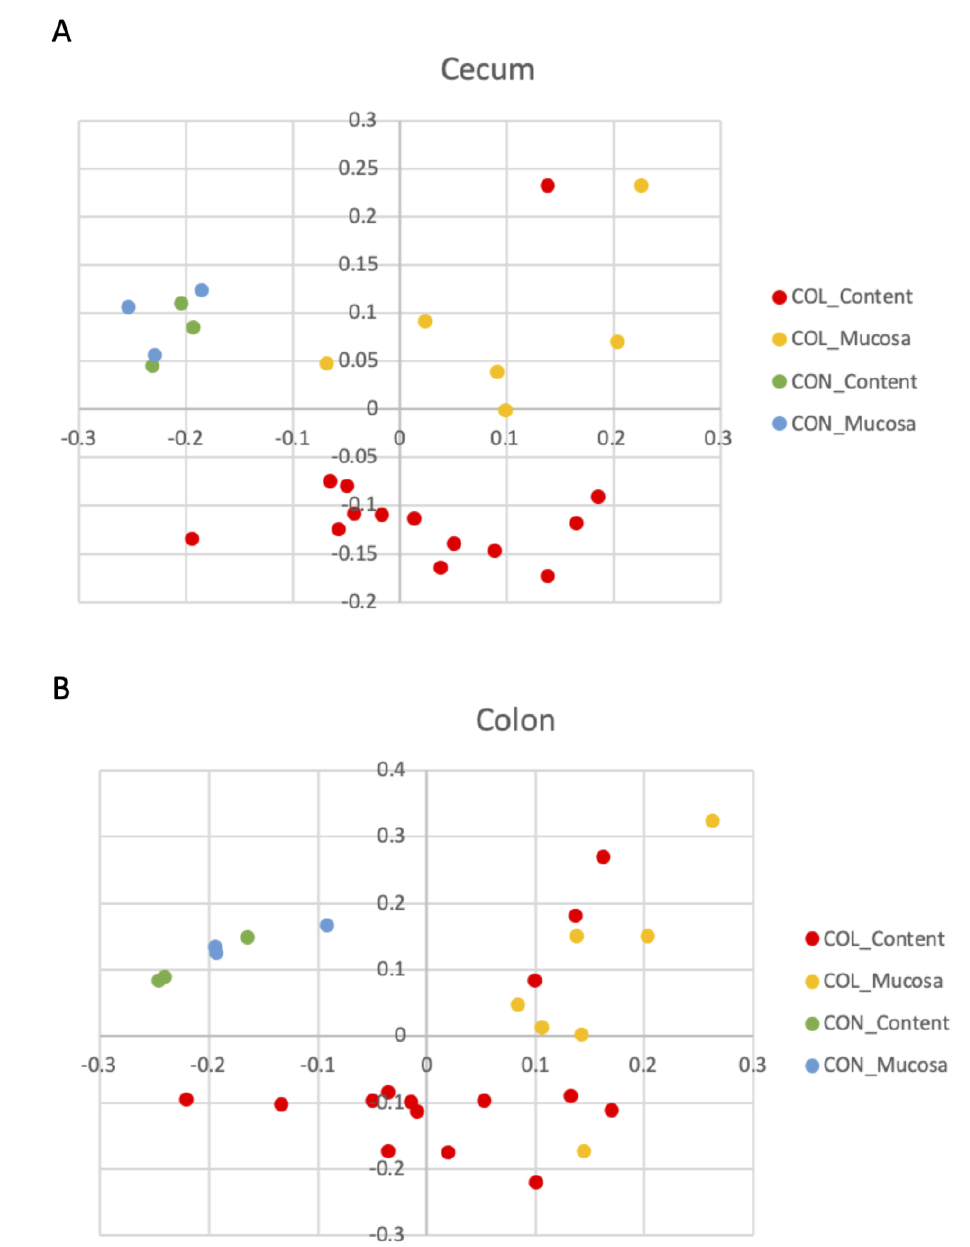
Figure 2. Principal coordinate analysis (PCoA) illustrating similarities in community composition of bacteria present in the lumen and content of the cecum ( A ) and colon ( B ) of healthy (CON) horses and horses with colitis (COL).